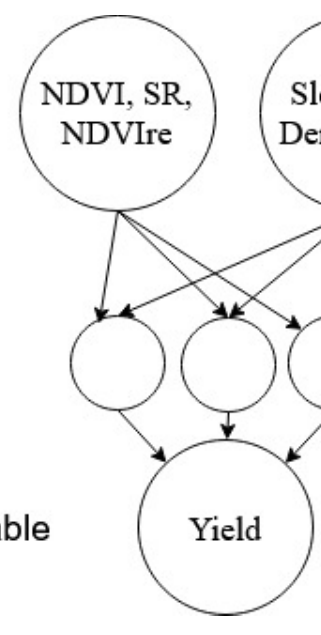
Figure 5. ANN multilayer perceptron network (MLP) for crop yield prediction.